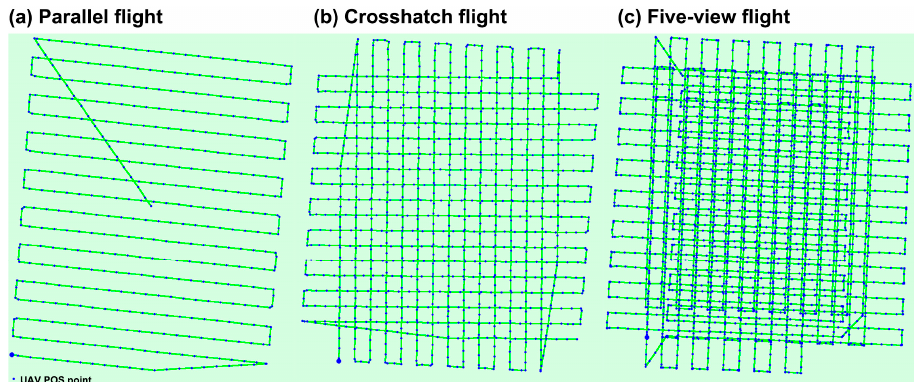
Figure 3. Flight pattern for ( a ) parallel flight, ( b ) crosshatch flight, and ( c ) five-view flight.